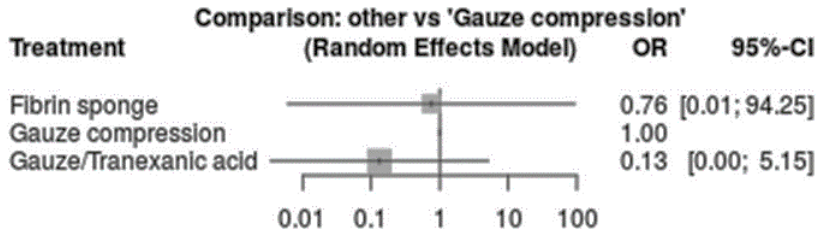
Figure 4. Intervention regarding the local haemostatic agents application compared to “gauze compression”.